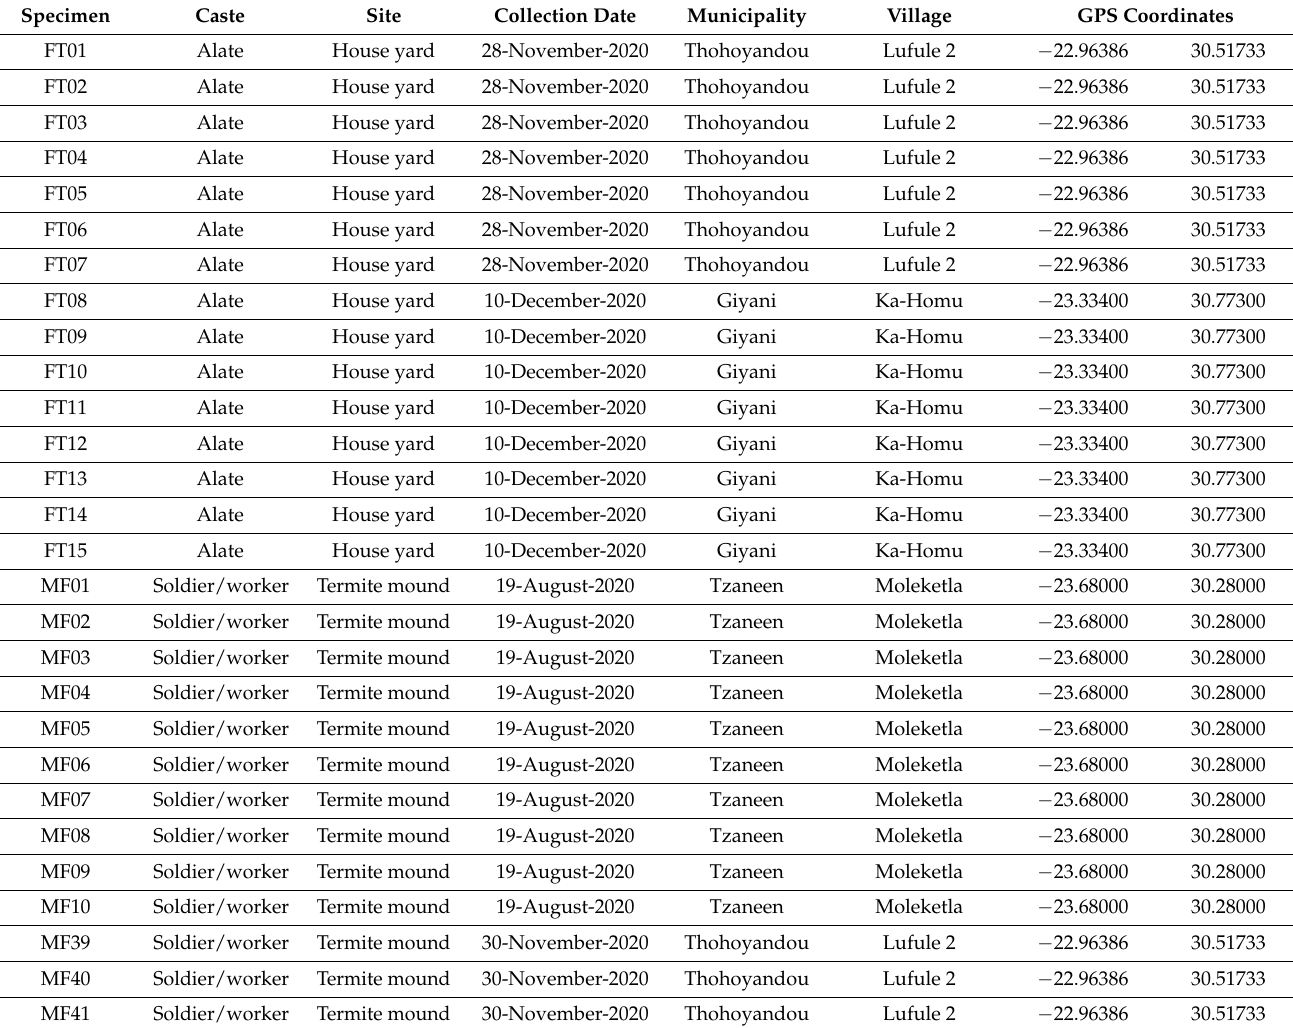
Table 1. Specimens of African Macrotermes collected in the Limpopo Province of South Africa for preliminary assessment of species diversity in the region based on COI